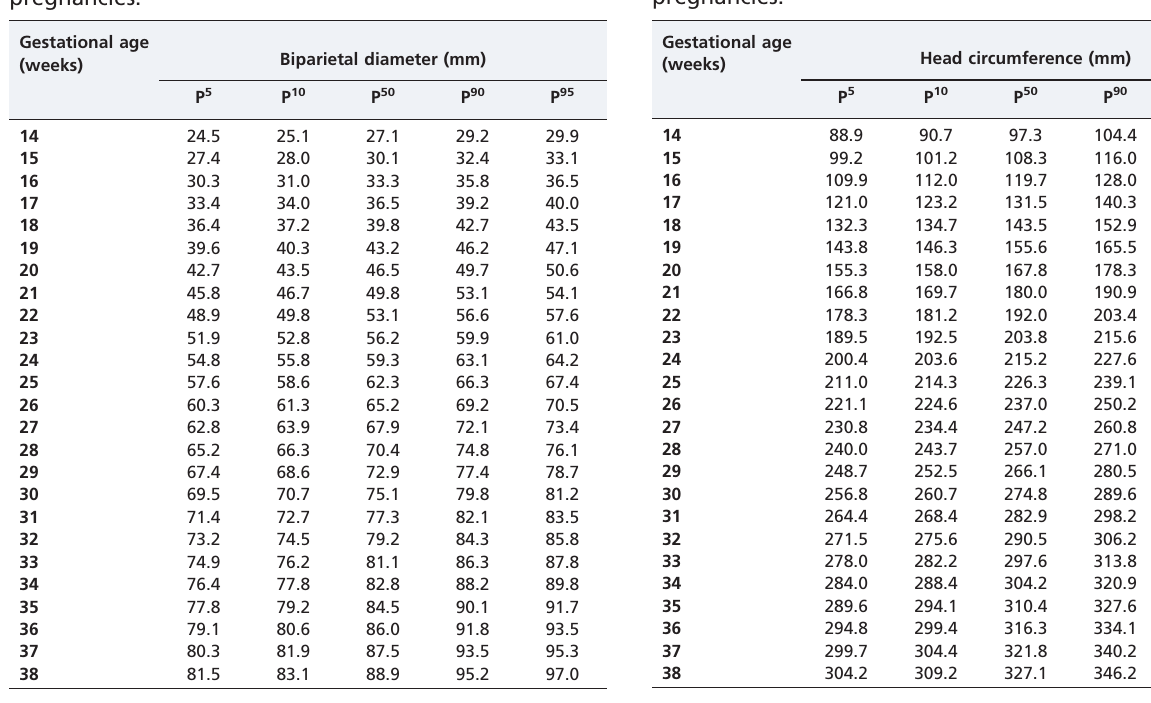
Table 3 - Longitudinal reference ranges for head circumference based on 807 ultrasound examinations performed on 250 fetuses from 125 uncomplicated, twin